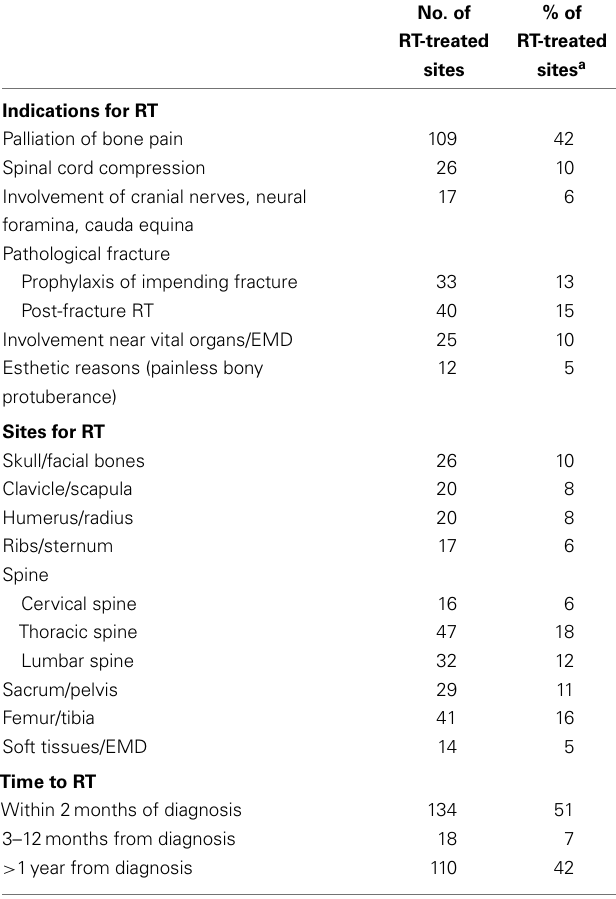
Table 2 | Indications, sites of treatment, and time to treatment of 262 radiotherapy courses in 149 patients with multiple myeloma